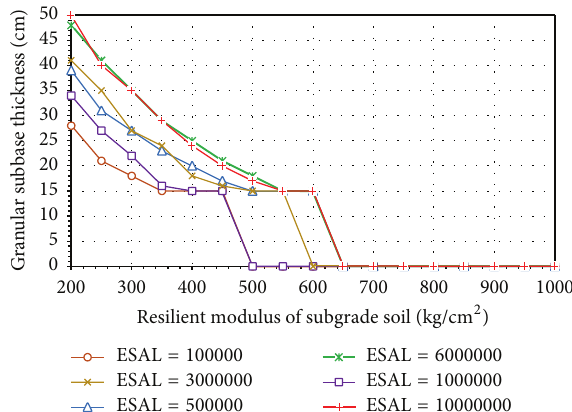
Figure 4: Optimal design thickness of granular subbase for sec- ondary rural